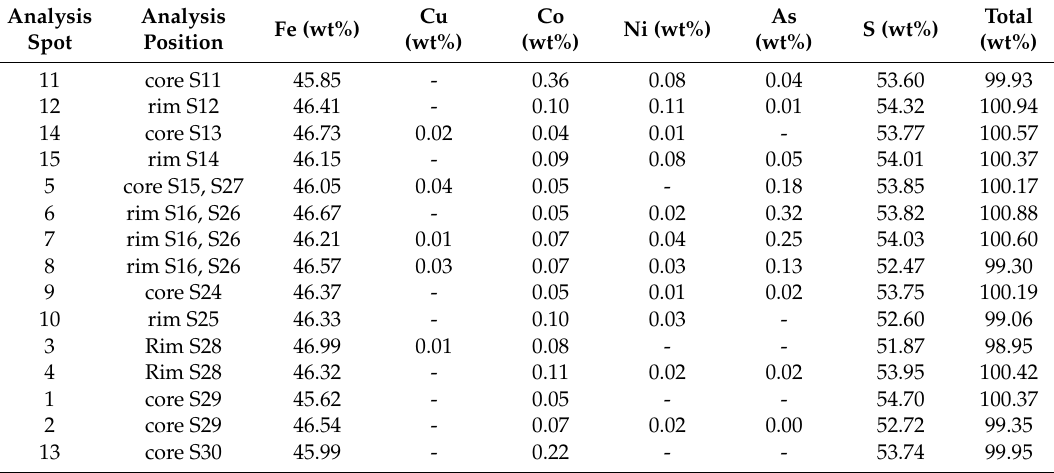
Table A2. Results of the EPMA analysis of pyrite from the South Deep